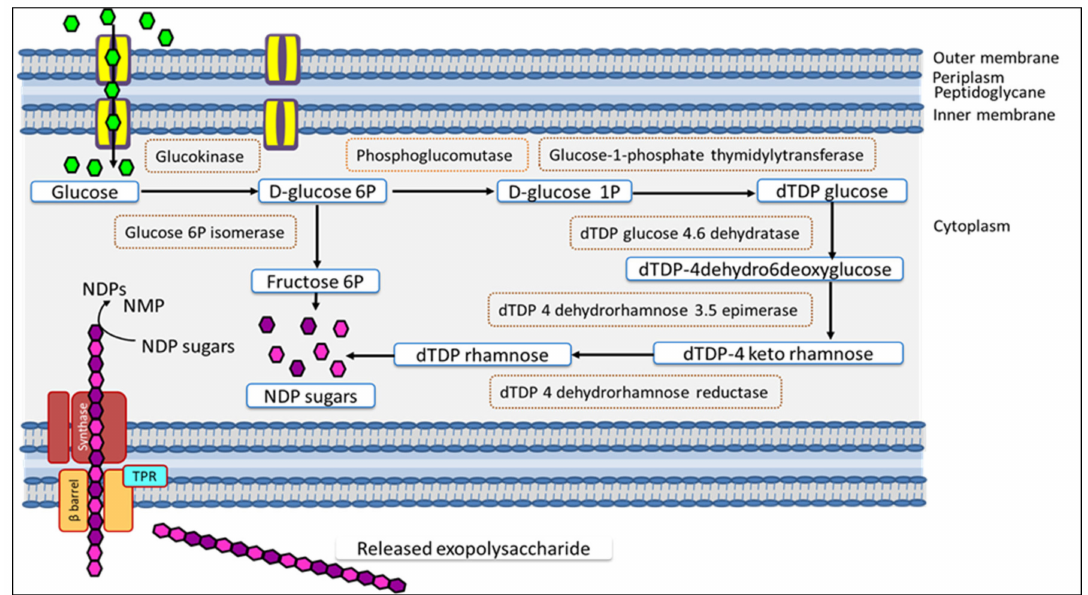
Figure 9. Genes identified for the native exopolysaccharide biosynthesis nEPS in H. desertis G11 from the genomic data. Results obtained from tBLASTn analysis and the synthase-dependent pathway for the assembly and transport of nEPS. Details are provided in the Supplementary Data Table S1. dTDP rhamnose, TPR: tetratricopeptide repeat protein, β -barrel: outer-membrane porin. Synthase complex composed of glycosyltransferase (GT) and